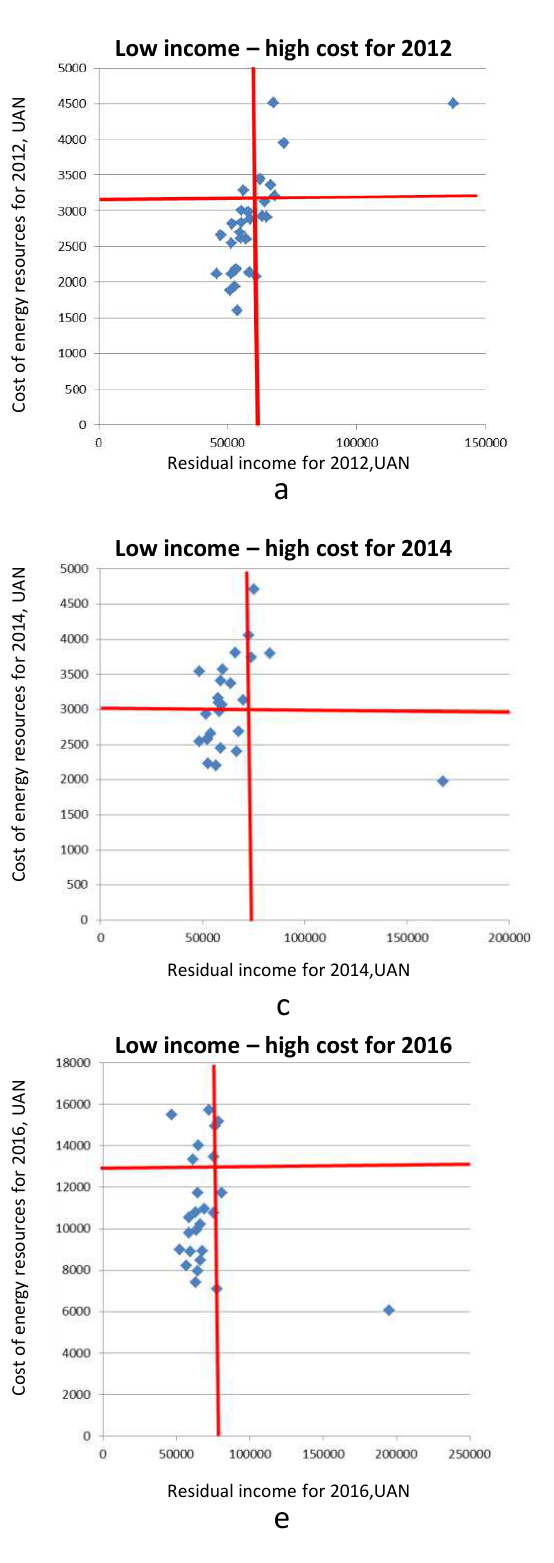
Figure 2. The “fuel poverty” modeling outcomes for Ukraine’s regions as a result of high energy costs and low household